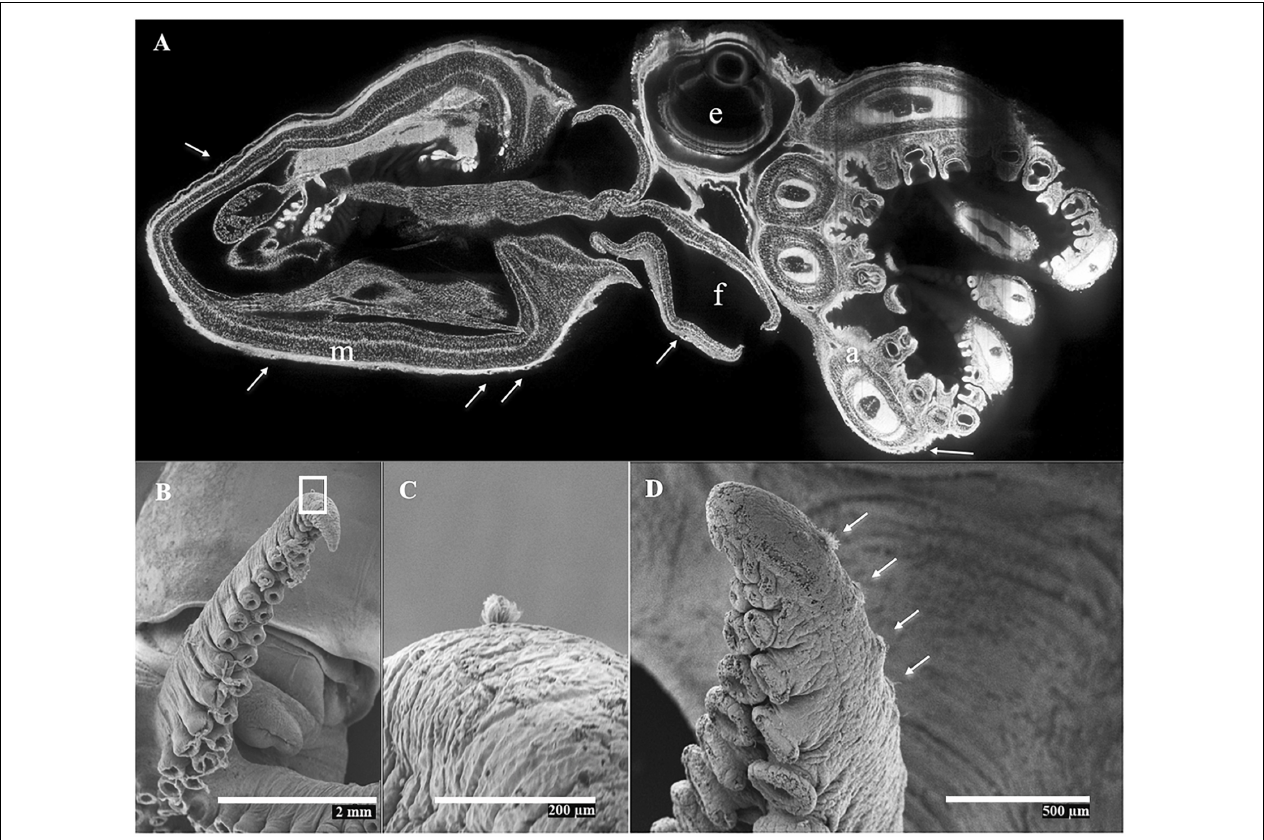
FIGURE 10 | Octopus vulgaris . (A) Mid-sagittal SPIM image from a cultured individual aged 50 days, ML 5.8 mm, labeled with Evans blue and excited at 638 nm. Note the few Kölliker’s organs (KO; white arrows) present on skin of mantle (m), funnel (f), and arms (a); e, (eye). (B–D) SEM images showing generation of new KO during the early benthic stage. (B) left arm III, with n = 30 suckers from a cultured, recently benthic individual ML 9.3 mm (measured fresh), age 60 days, showing a KO near arm tip. (C) Magnified image of rectangle in (B) , showing semi-everted KO; (D) , right arm III, with n = 52 suckers, from a wild benthic individual, ML 8.4 mm ML, showing KO (white arrows) near arm